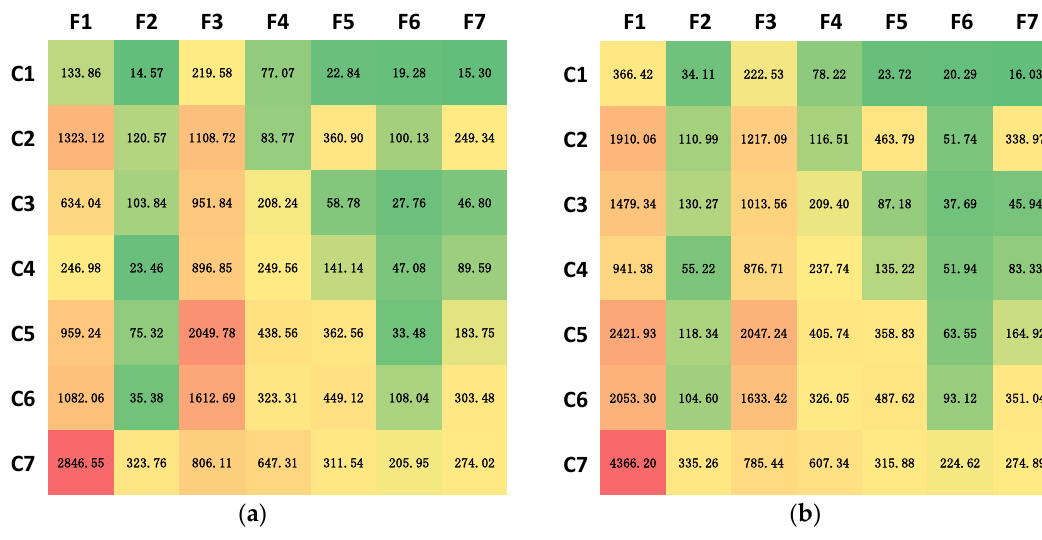
Figure 9. Shape descriptor of lakes in Figure 4: ( a ) Shape descriptor of the lake in scale of 1:10,000 and ( b ) shape descriptor of the lake in scale of 1:50,000.